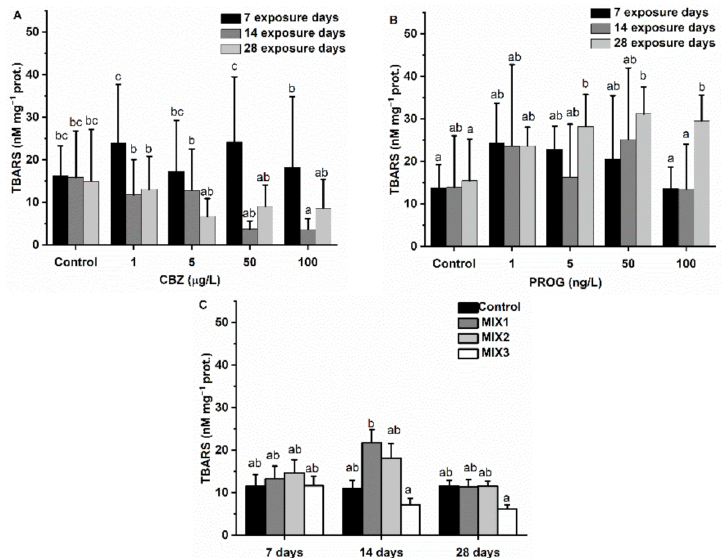
Figure 9. Changes in LPO concentration in the liver of Danio rerio exposed to ( A ) CBZ, ( B ) P4, and ( C ) binary mixtures of CBZ and P4 for 7, 14, and 28 days. Data are expressed as mean ± standard deviation of fifteen replicates ( n = 15). Different letters show significant differences at p < 0.05 after a two-way ANOVA followed by Tukey’s post hoc test.